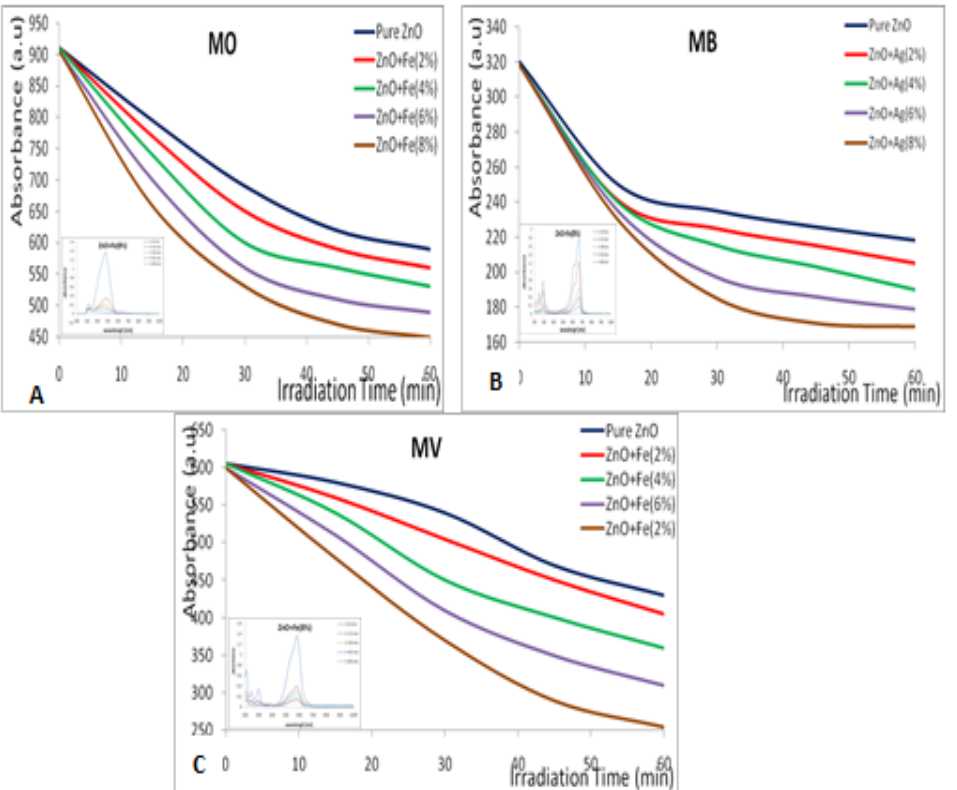
Fig. 9: Absorbance of an aqueous solution with irradiation time of the ZnO films immersed in it. (A) for methyl orange (MO). (B) methyl blue (MB). (C) methyl violet (MV). Inset: absorption spectra of aqueous solution (100 mg/l) degraded by a ZnO